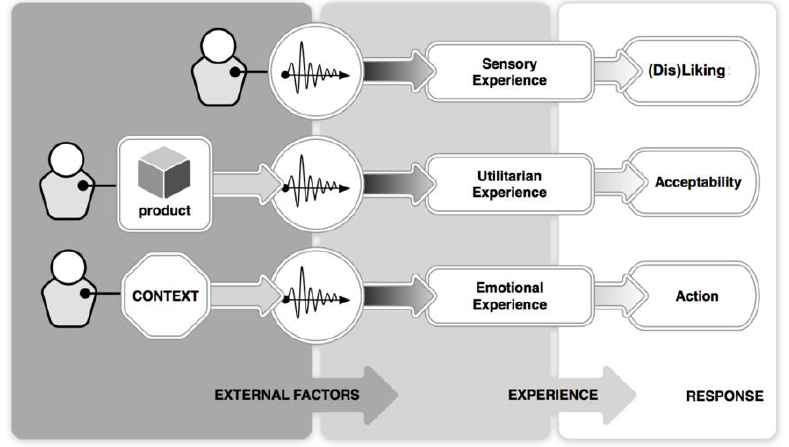
Figure 2. Product sounds evoke different experiences (sensory/utilitarian/emotional) depending on external factors (Adapted from [69]).